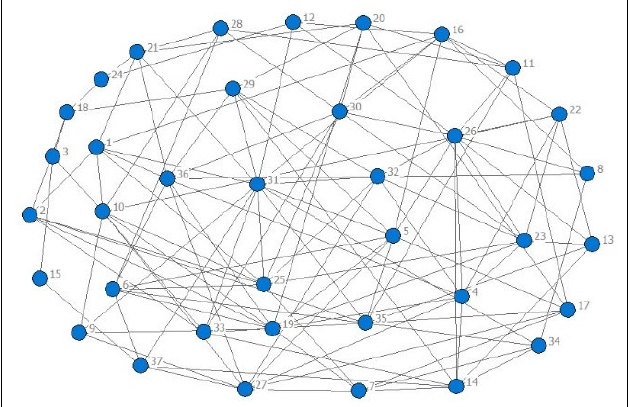
Figure 4. Graph of equity analysis (partial).